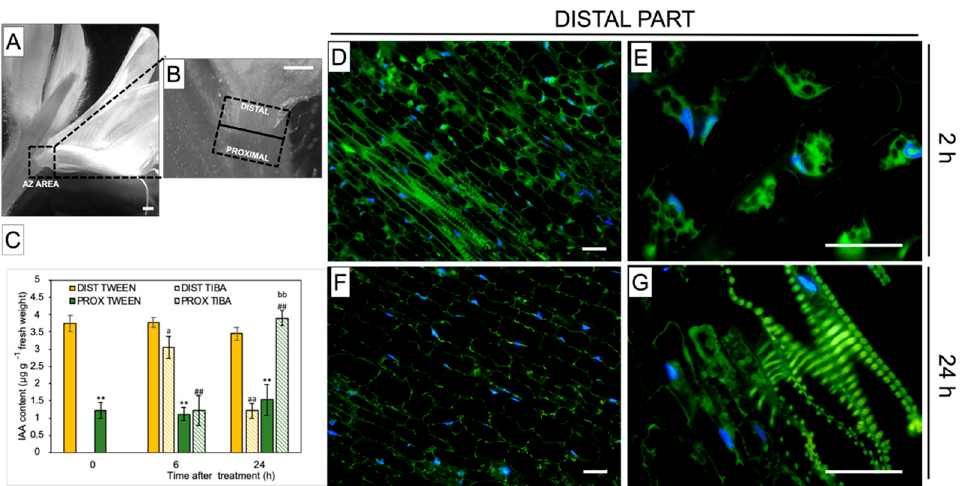
Figure 2. Different AZ regions exhibiting the specific gradient of IAA, which was reversed by an exogenous polar auxin transport inhibitor . An image of yellow lupine flower presenting the abscission zone (AZ) area, which is marked by a black dashed-line box ( A ). Magnification indicating various regions of the AZ used for analyses ( B ). Distal and proximal parts are located ≈ 1 mm above and ≈ 1 mm below the AZ, respectively (marked by dotted black lines). The levels of IAA in the different regions of the AZ following TIBA (2,3,5-triiodobenzoic acid) application ( C ). A solution of TIBA (0.05 mM in 0.05% Tween 20) or 0.05% Tween 20 was applied locally on the inactive AZ. The tissue fragments containing AZ were dissected 6 h or 24 h after treatments and divided into a proximal (PROX) and a distal (DIST) part. Averages and SD of three biological replicates. t -test: ** p < 0.01, proximal versus distal part in the Tween 20-treated AZ for different times after application; ## p < 0.01, proximal versus distal part in the TIBA-treated AZ for different times after application; a p < 0.05 and aa p < 0.01, TIBA- treated distal part versus Tween 20-treated distal part for different times after application; bb p < 0.01, TIBA- treated proximal part versus Tween 20-treated proximal part for different times after application. The localization of IAA in the distal area of the AZ 2 h and 24 h after the TIBA local application ( D – G ). Images ( E ) and ( G ) present higher magnification images of ( D ) and ( F ), respectively. The green fluorescence corresponds to the IAA presence. Nuclei were visualized using a blue-fluorescent DAPI stain. Scale bars: 2 mm ( A , B ) and 40 µM ( D – G ).